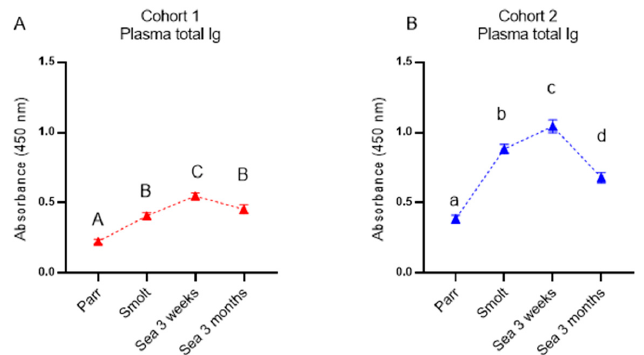
Figure 5. Total immunoglobulin (Ig) in plasma from Atlantic salmon from cohort 1 ( A ) and cohort 2 ( B ). Samples are analyzed by ELISA and at an absorbance of 450 nm. Data are presented as mean with SEM (n = 12–15 individuals at each time-point). Data points within one cohort not sharing the same letters are significantly different (ANOVA, LSD test, p < 0.05).